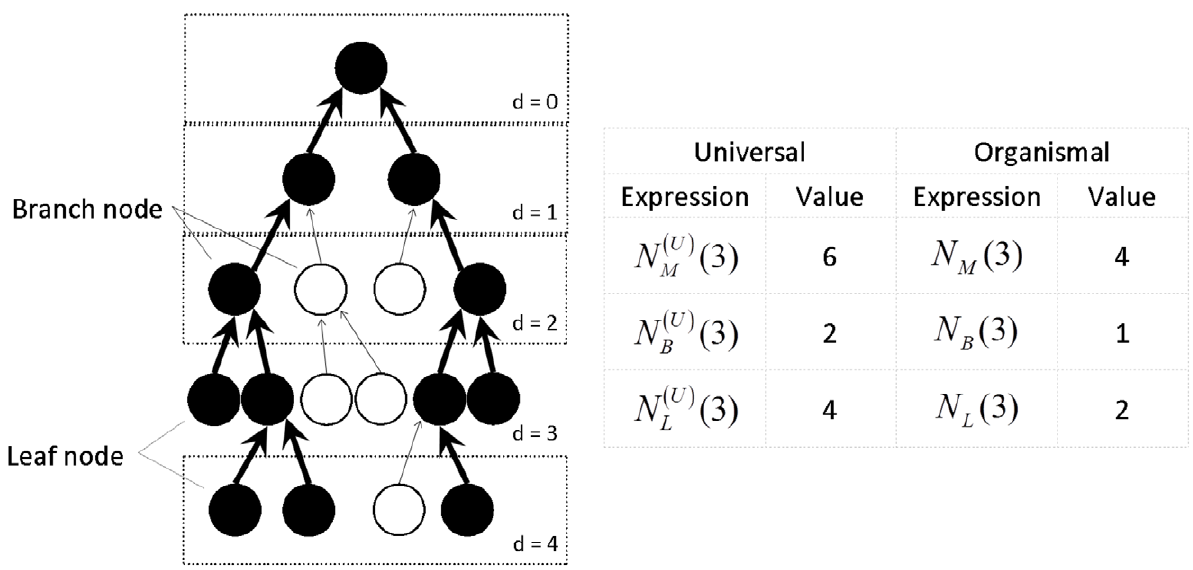
Figure 1. An example of organism-specific metabolic network and the corresponding universal network. The organism-specific metabolic network (filled circles and thick edges) is always a subset of the universal network (the entire tree). Nodes are divided into layers based on their distance d from the root of the tree. Variables N U ð Þ network are illustrated using the layer d ~ 3 as an example.